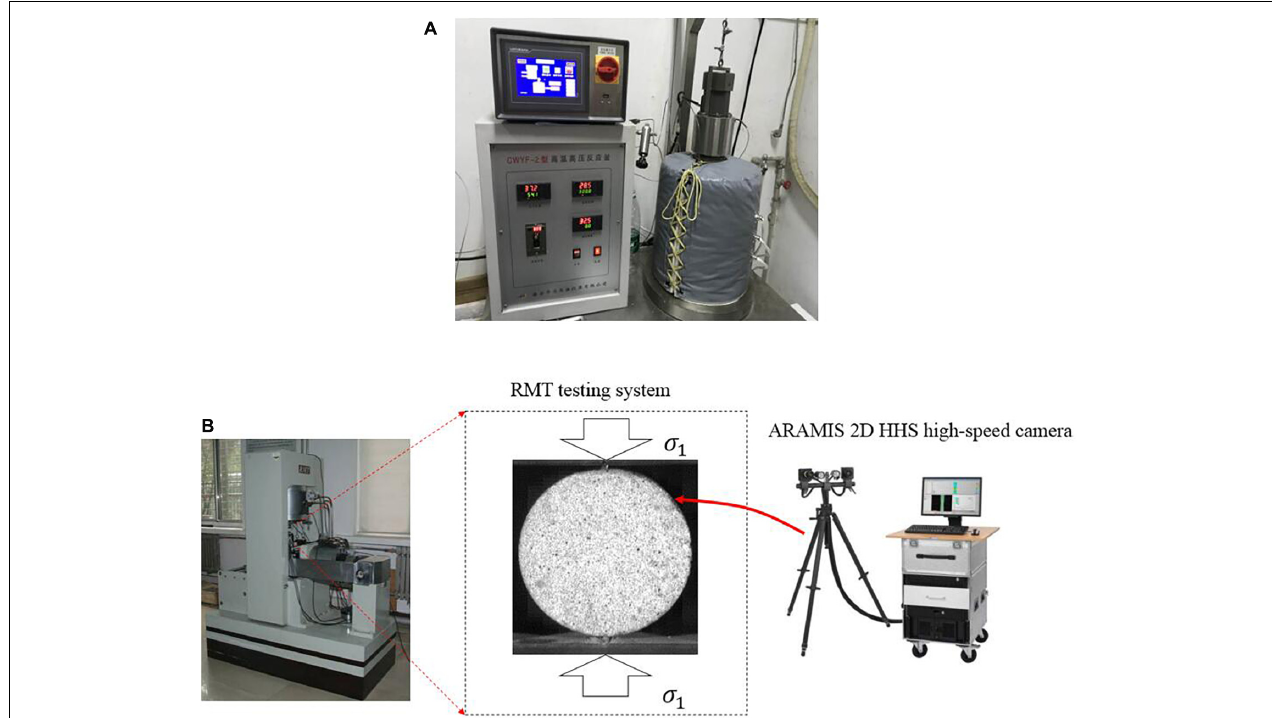
FIGURE 3 | Laboratory setup for: (A) the HTHP autoclave; (B) the schematic diagram of the compression split test.